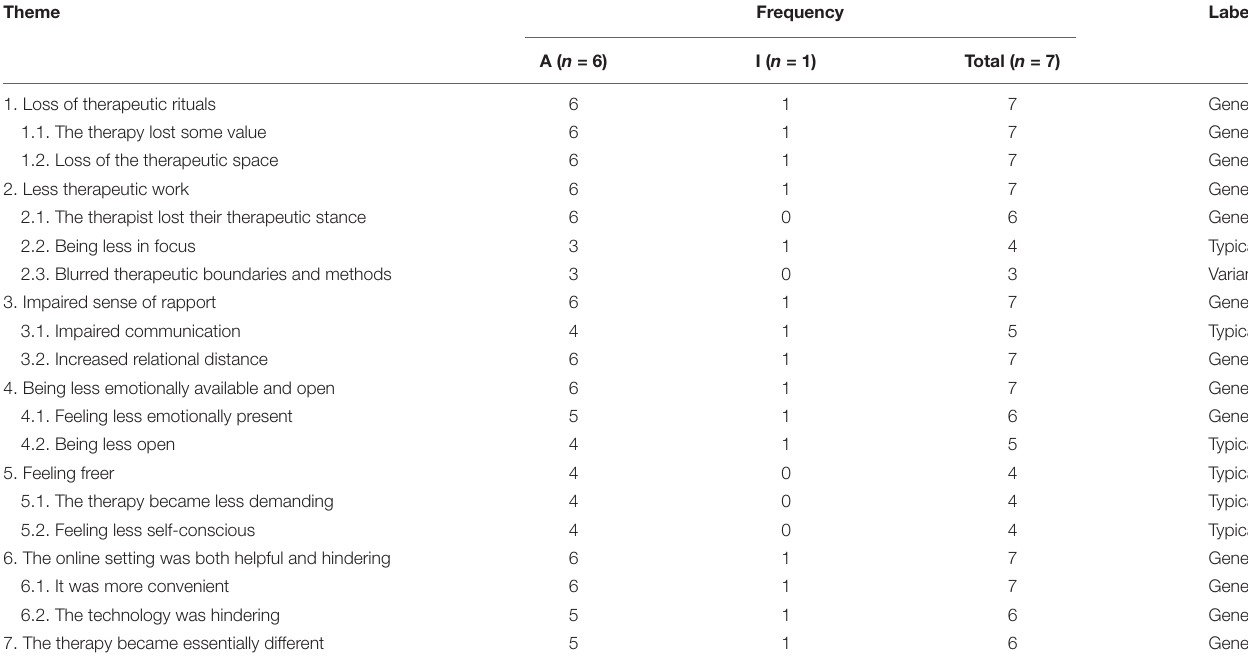
TABLE 1 | Themes and subthemes in the participants’ experiences of transition to telepsychotherapy.